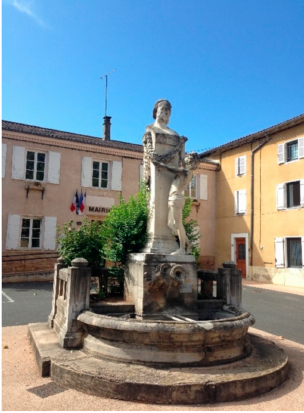
Figure 3. Statue of Claude Bernard on the village square in Saint Julien in